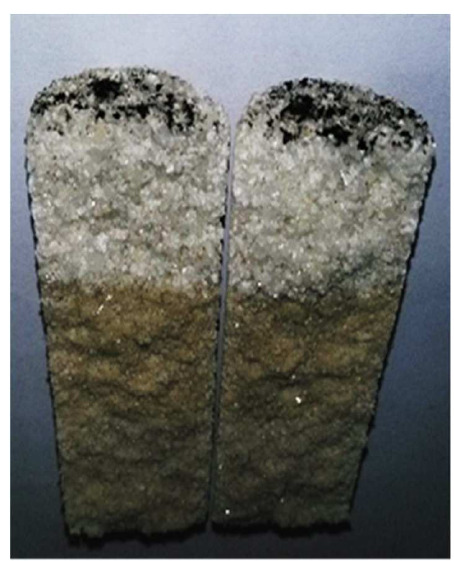
Figure 18. End face accumulation phenomenon.